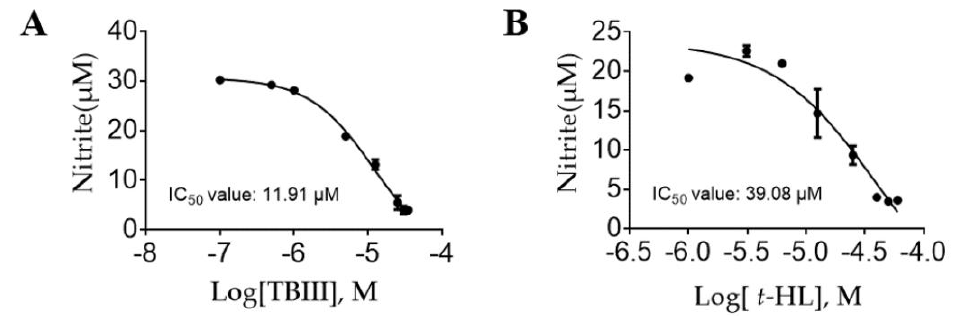
Figure 2. Inhibitory effects of TBIII ( A ) and t -HL ( B ) in LPS-stimulated N9 microglial cells. Cells were pretreated with different concentrations of TBIII and t -HL 1 h prior to the addition of LPS (100 ng/mL) and were further incubated for 24 h. NO production was determined by using the Griess reagent. IC 50 values and curve fitting were determined using Graphpad Prism (GraphPad, Avenida, CA, USA). Data represent mean ± S.E.M.